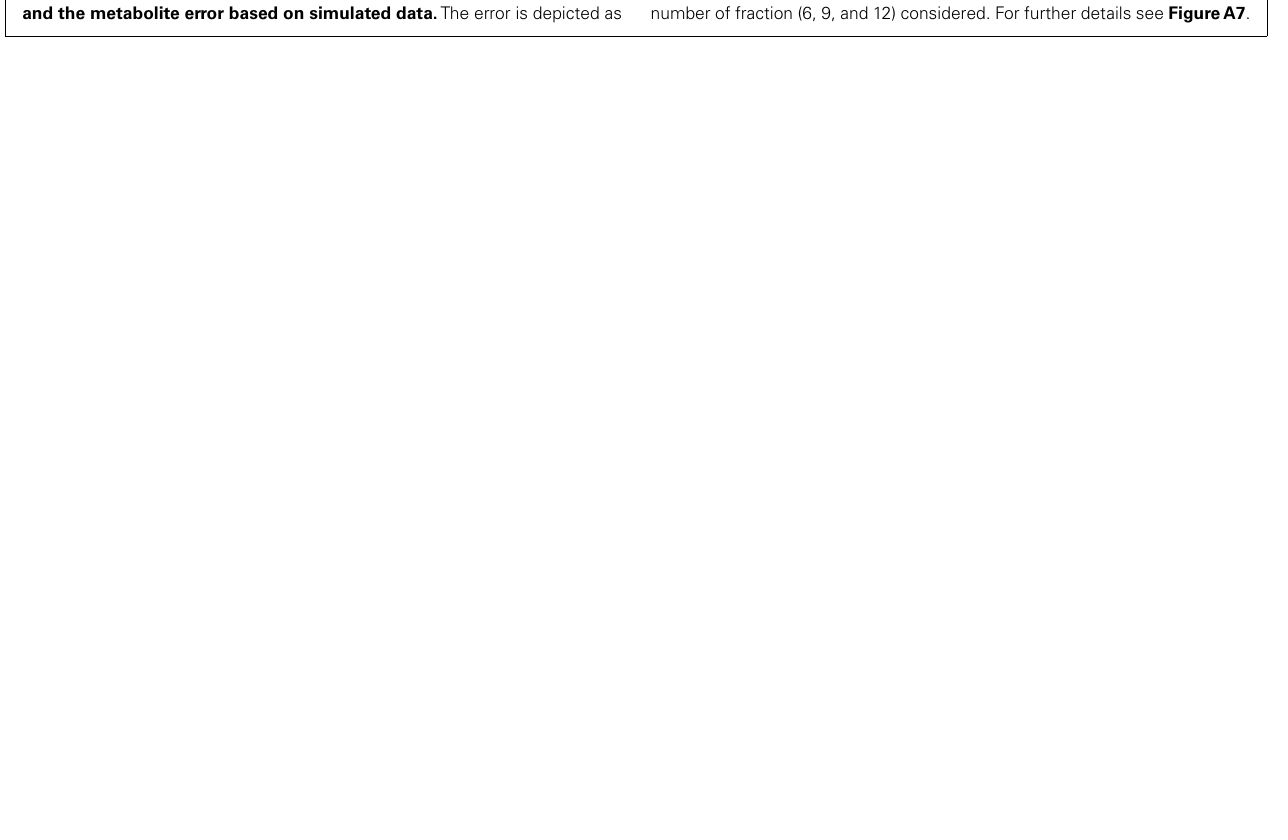
FIGUREA8 | Percentile (99%) calculation error of compartmental abundances in dependence of the between-compartment separation and the metabolite error based on simulated data. The error is depicted as